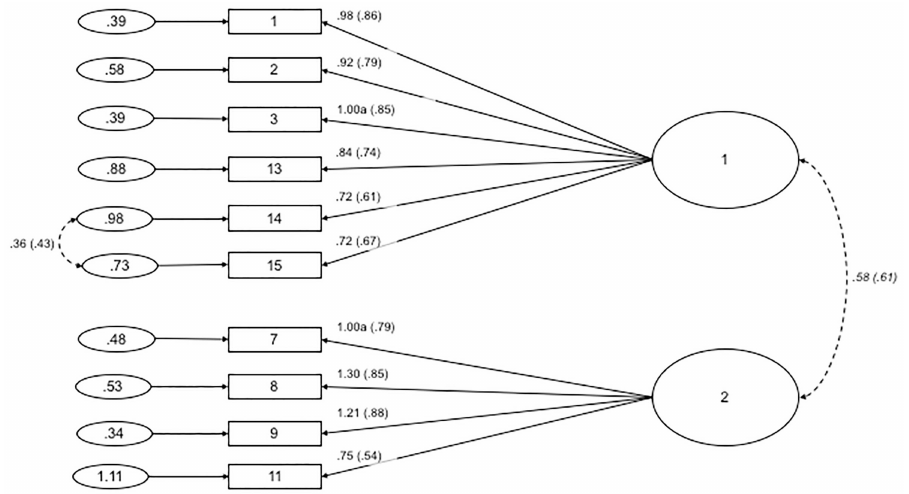
Fig 5. Path diagram and estimatesfor the two-factor Generic Conspiracist Beliefs Scale. Item numbers in the figure reflect the item number in Table 6. The large circles are the latent construct, with the rectangles representing measured variables, and the small circles with numbers are the residualvariables(variances). The factor loadingsare standardised in parenthesises, and the unstandarised values outside, with both being reportedfollowingthe guidelinesof Kline [42]. Significance levels were determinedby critical ratios (all p < .001). Estimates of covariancebetweenexogenous variablesare displayedin italics. The factor loadingswere fixed at the indicatedvalue